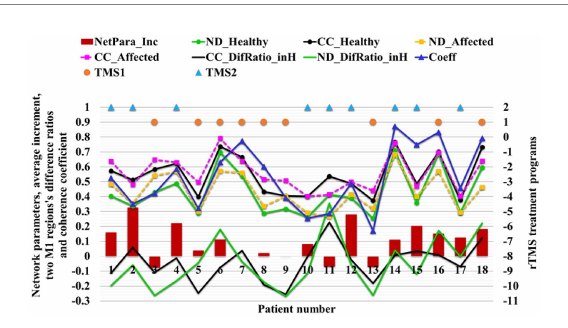
FIGURE 12 Relationship between network parameters and rTMS treatment